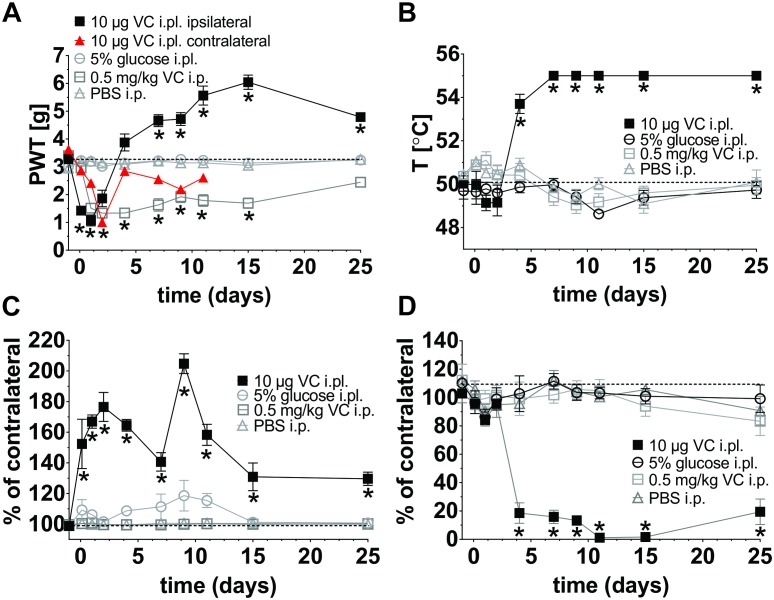
Behavioral characterization of a novel mouse model of vincristine-induced peripheral neuropathy (VIPN). Single daily injection of vincristine (i.pl; 10 μl solution containing 10 μg or i.p.; 10 μl/g solution containing 0.5 mg/kg) or vehicle (i.pl; 10 μl 5% glucose or i.p.; 10 μl/g PBS) were administered using the schedule in Figure 1. Dotted lines indicate baseline values. (A) Mechanical paw withdrawal threshold (PWT) following vincristine administration, measured using an electronic von Frey instrument (MouseMet, TopCat Metrology. (B) Thermal PWT following vincristine administration assessed using MouseMet Thermal (TopCat Metrology). (C) Paw thickness 30 min after injection was assessed using a digital Vernier caliper (Kincrome, VIC, Australia). (D) Ipsilateral paw print area expressed in percent of the contralateral paw following vincristine administration was assessed using the CatwalkXT platform (Noldus Information Technology, Netherlands). Print area is the average of paw contact area with the glass platform (in cm2). Statistical significance was determined using two-way ANOVA with Tukey’s multiple comparisons test; the experimental groups (vincristine i.pl. or i.p.) were compared to the respective vehicle control group (i.pl., 5% glucose or i.p., PBS). No significant differences between the sexes were detected. All data are shown as mean ± SEM; n = 6 for all groups (3 females and 3 males). ∗p <0.05.